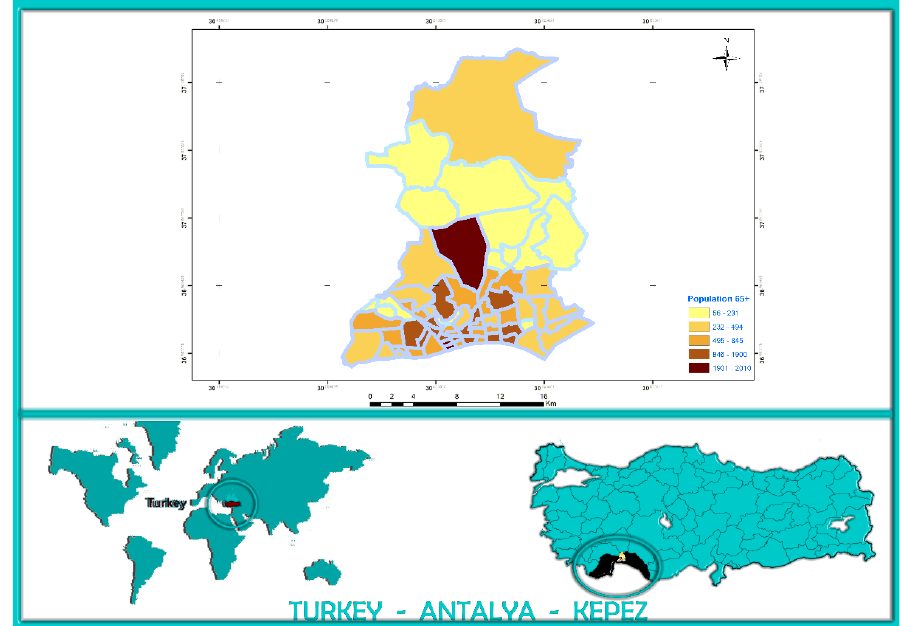
Figure 1. Kepez district and neighbourhood